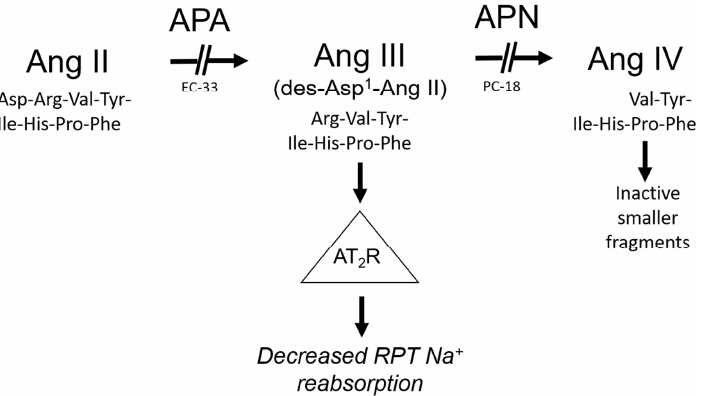
Figure 1. Metabolism of angiotensin II (Ang II) to angiotensin III (Ang III) and smaller inactive peptide fragments by aminopeptidases A (APA) and N (APN), respectively. RPT, renal proximal tubule; EC-33, APA inhibitor; PC-18, APN inhibitor.